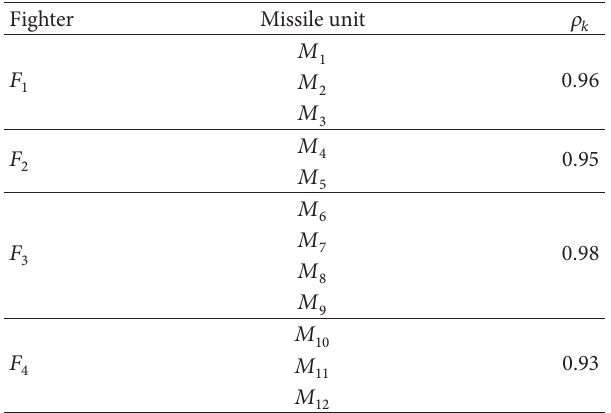
Table 6: Pilot operation factor table. Fighter Missile